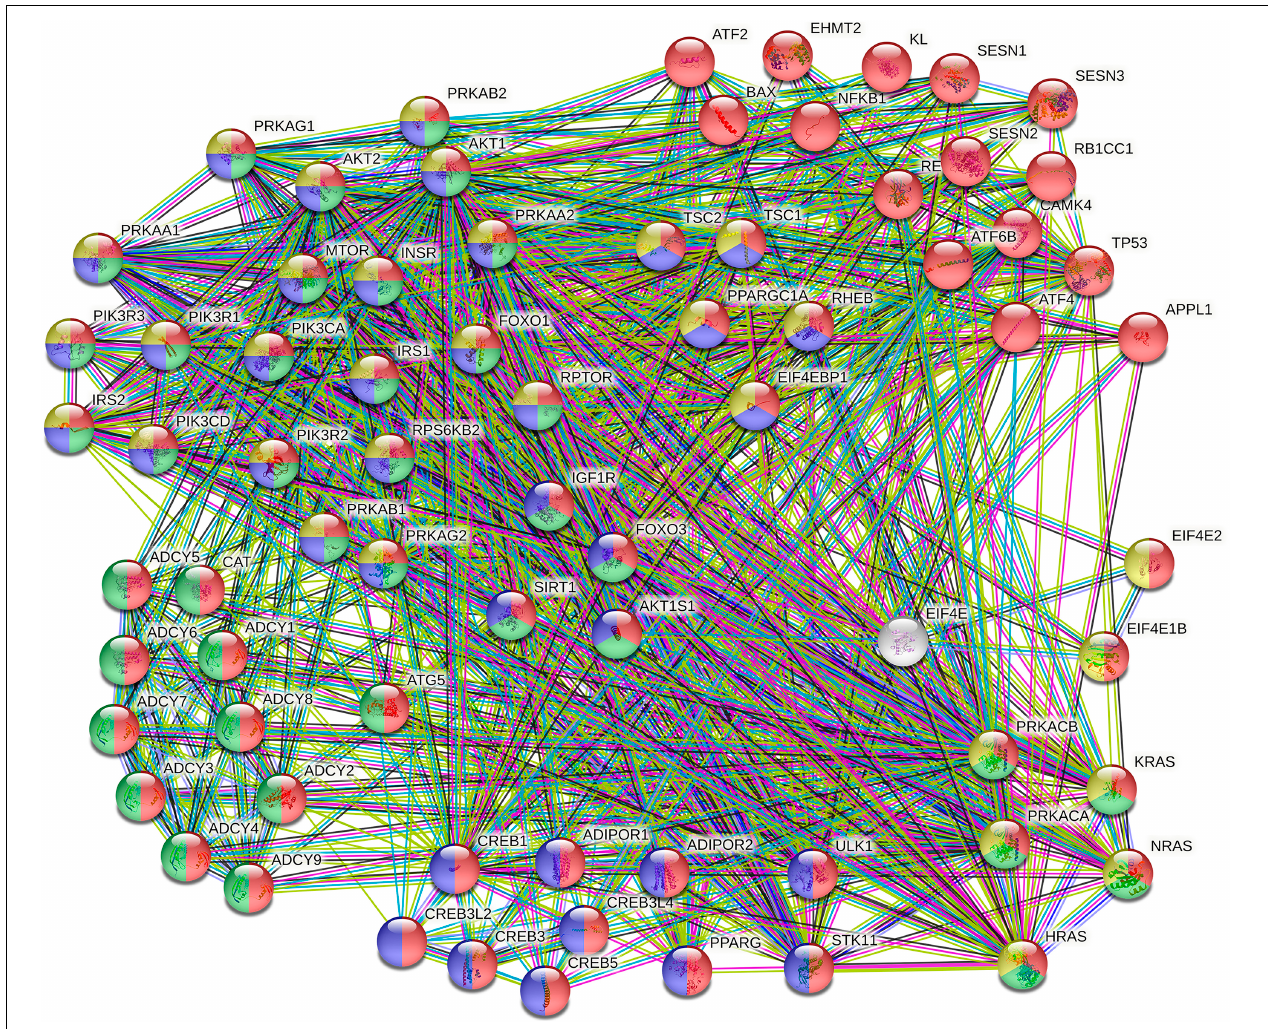
FIGURE 4 | Protein–protein interaction between gene products of the longevity regulating pathway. Clusters are colored based on the Search Tool for Retrieval of Interacting Genes/Proteins (STRING) analysis. The proteins involved in the longevity regulating pathway are highlighted in red and green colors (KEGG pathways: hsa04211 and hsa04213, respectively). In contrast, AMPK signaling proteins (hsa04152) and the insulin signaling pathway proteins (hsa04910) are shown in blue and yellow colors,